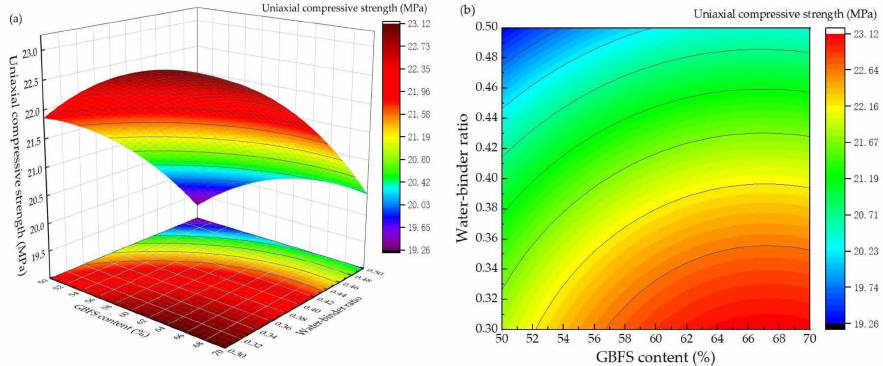
Figure 8. Effect of interaction between GBFS content and water-binder ratio on compressive strength: ( a ) response surface diagram; ( b ) contour